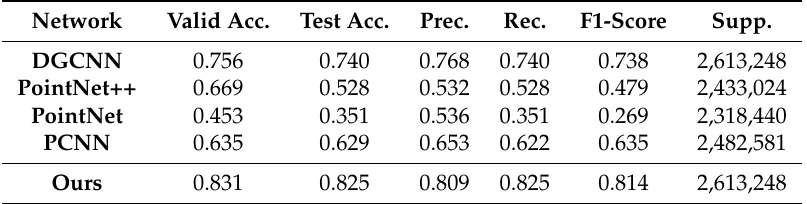
Table 5. Results of the tests performed on an unknown scene, training the network on the